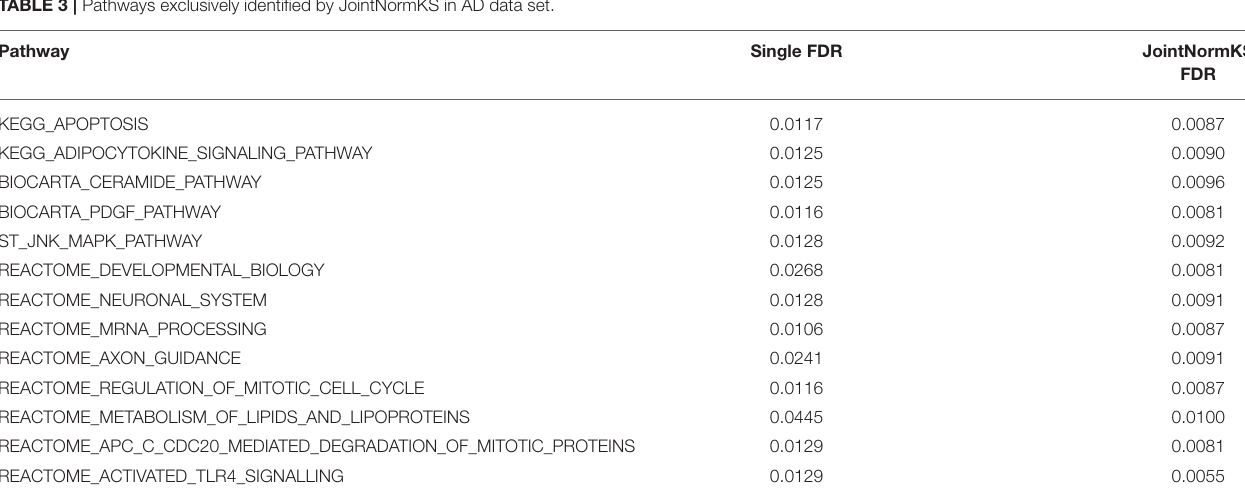
TABLE 3 | Pathways exclusively identified by JointNormKS in AD data